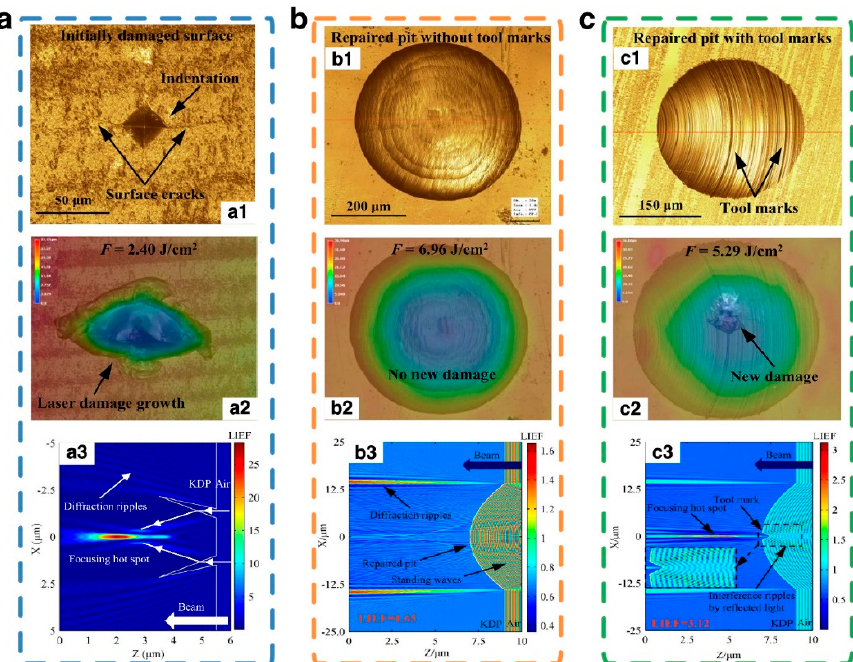
Figure 25. Morphologies of the various KDP surfaces before ( a1 , b1 , and c1 ) and after ( a2 , b2 , and c2 ) 355 nm-laser pulse irradiation. ( a ) Initial crack damaged surfaces; ( b ) Repaired pit without tool marks; ( c ) Repaired pit with tool marks. a3 , b3, and c3 are the light intensity enhancement factor (LIEF) distribution [18,105].